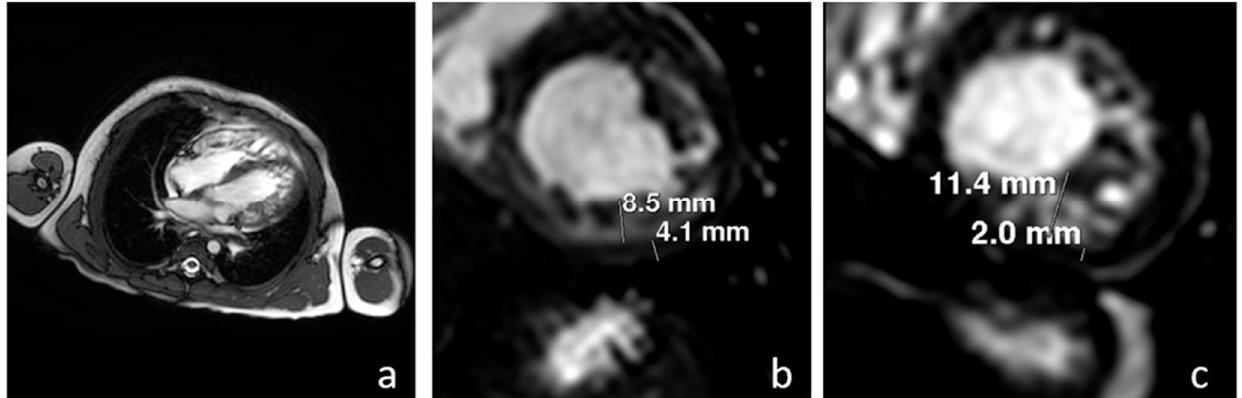
Figure 1. Cine MR performed after 12 months of therapy with the new protocol cipaglucosidase/miglustat, showing the presence of a biventricular non-compaction myocardium, evident in both the long-axis view ( a ) and the short-axis view, with an NC/C ratio of 8.4/4.1 in the medial segment of the left ventricle ( b ), and an NC/C ratio of 11.4/2 in the apex ( c ).